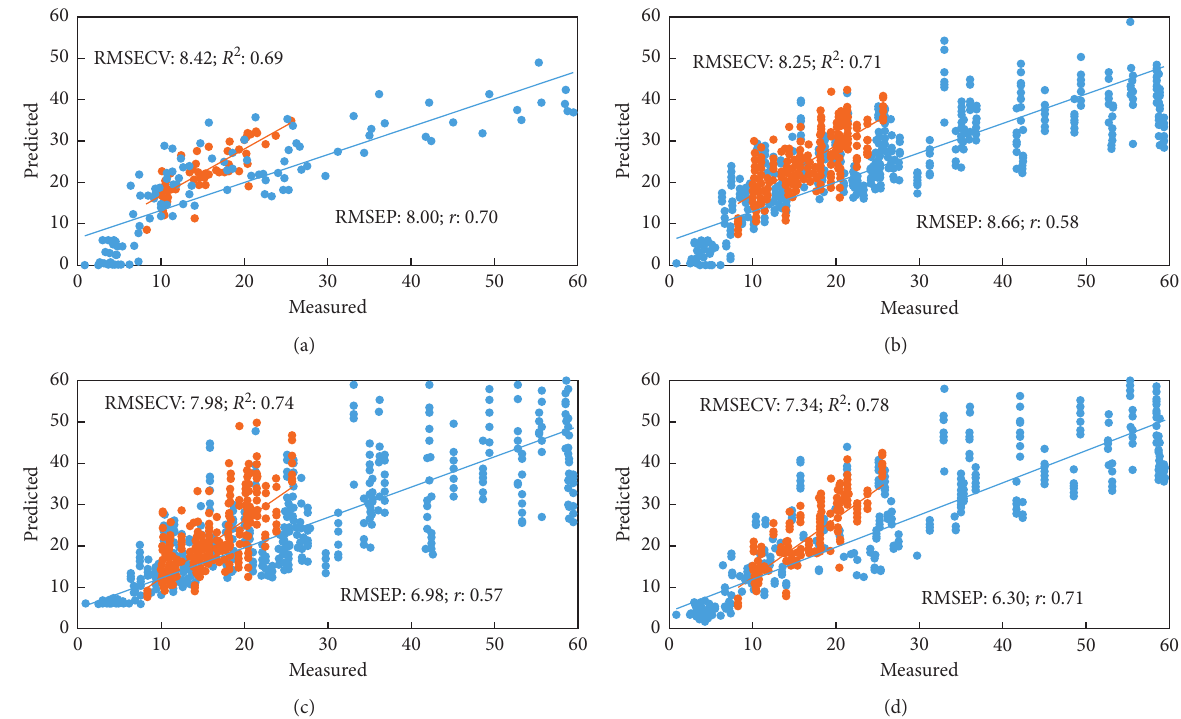
Figure 4: Measured vs. predicted scores of α -chaconine (mg kg − 1 ) in the calibration (blue) and prediction (red) sets with PLS models using (a) Hunter’s a ∗ values; (b) Hunter’s a ∗ /b ∗ values; (c) (a ∗ /b ∗ ) 2 values; and (d) multivariate values.